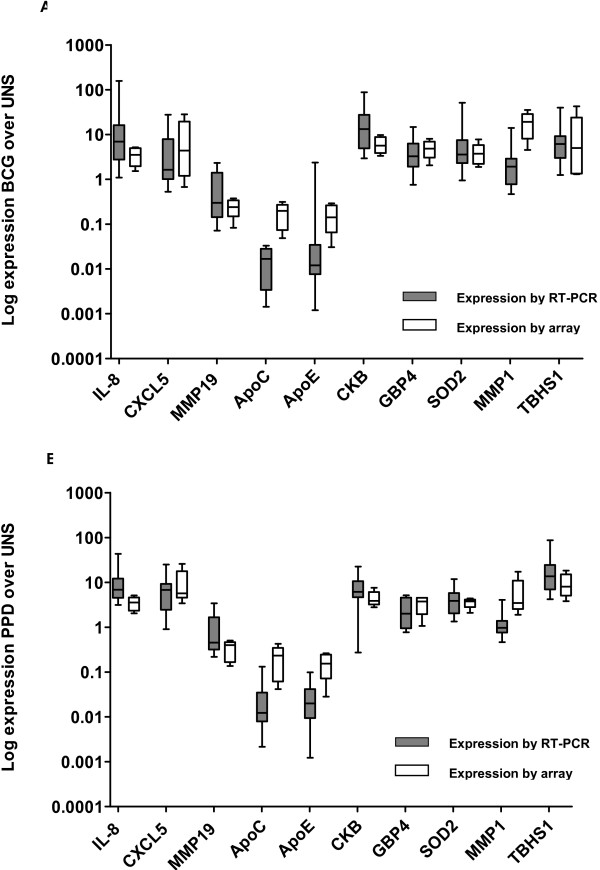
Comparison of expression of highly and moderately expressed genes using DNA microarray and real time RT-PCR. Gene expression shown is that in relation to media, for BCG (A), and PPD (B). Microarray analysis involved 5 infants, whereas real time RT-PCR analysis involved these 5 infants plus an additional 10 infants (total n = 15). Box plots represent median plus 95th, 75th, 50th and 25th percentiles.